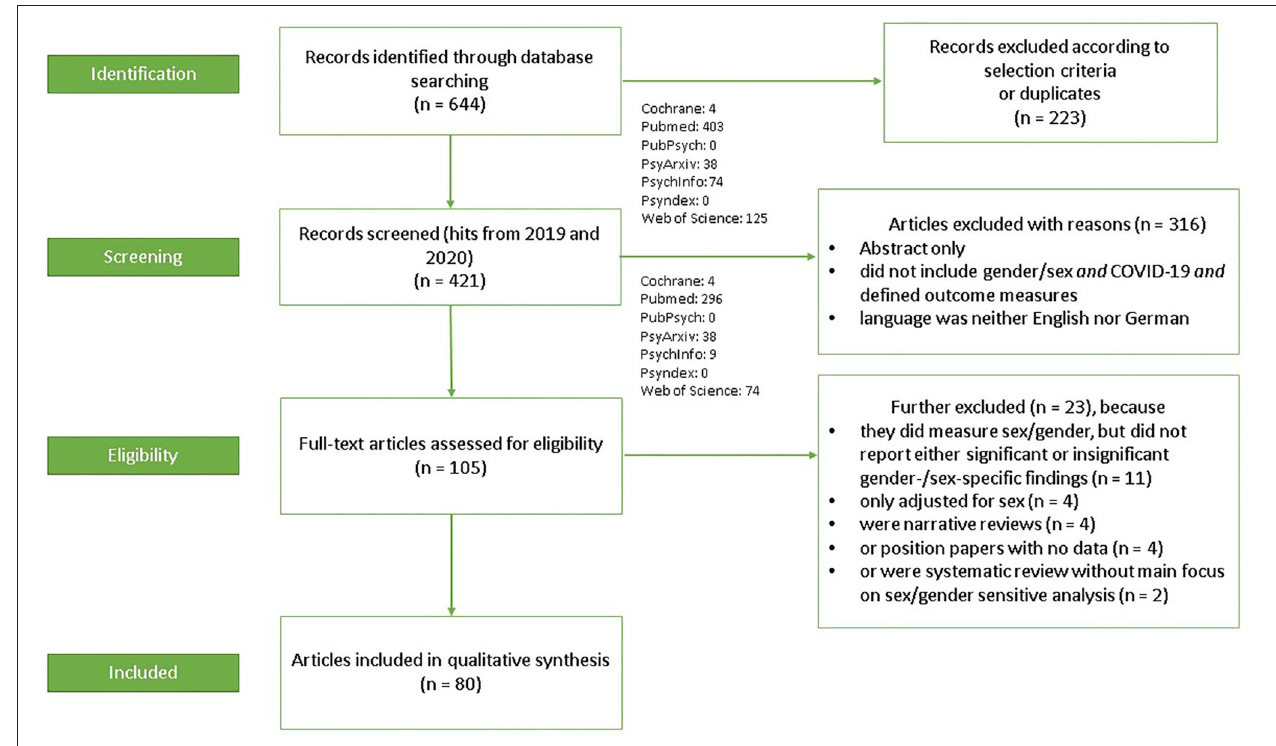
FIGURE 1 | PRISMA (Preferred reporting items for systematic reviews and meta-analyses) flow